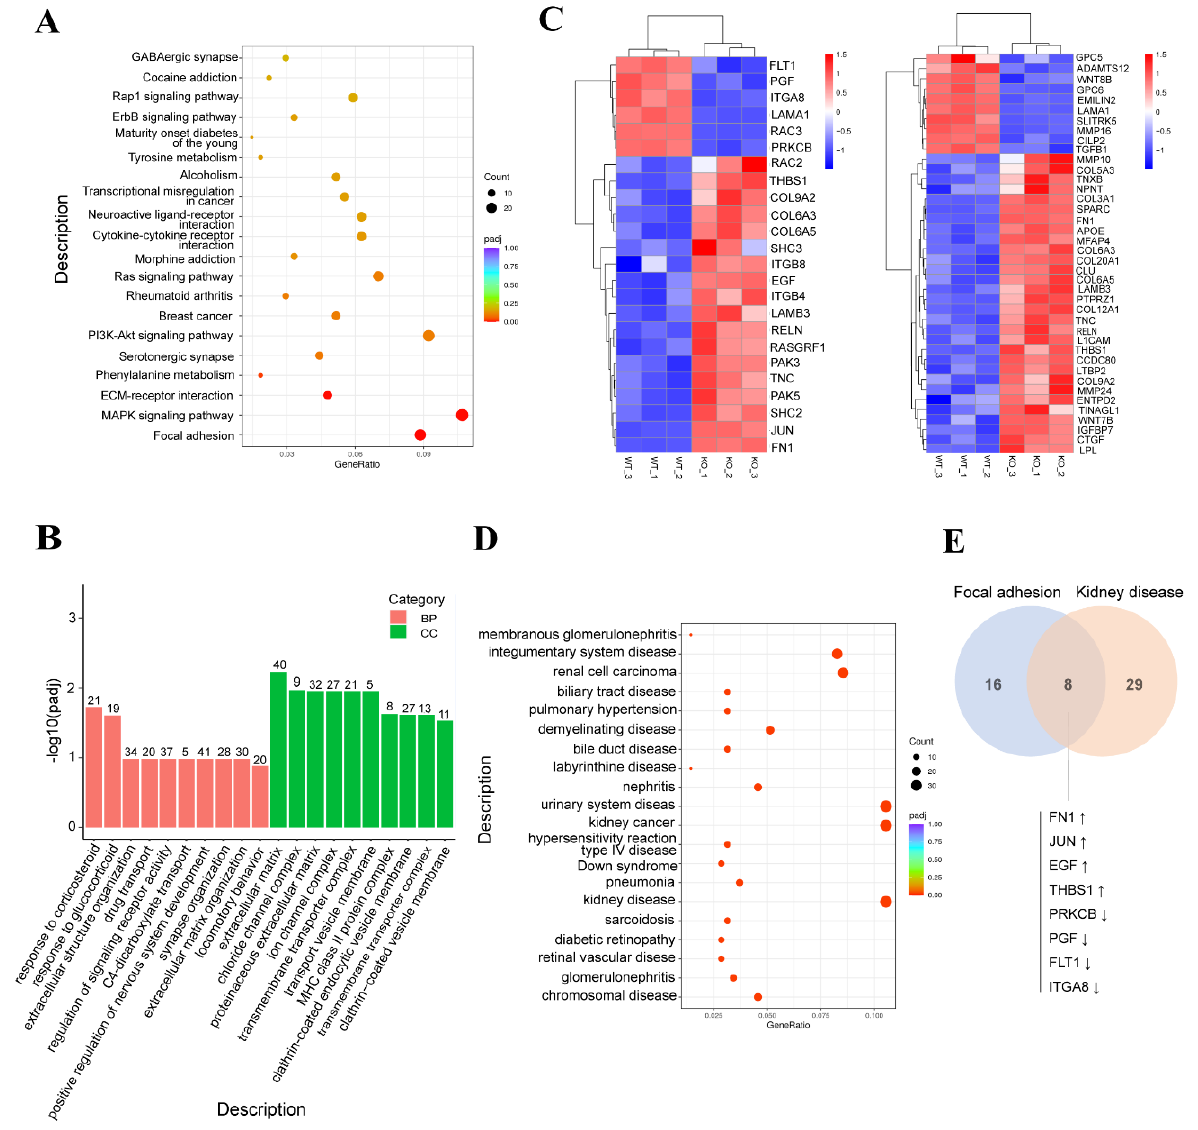
Figure 3. RNA sequencing analysis revealed differentially expressed genes (DEGs) enriched in two pathways. ( A ) KEGG pathway analysis of DEGs in WDR73 KO transcriptome. The top 20 most significantly enriched KEGG pathways are shown. ( B ) Gene Ontology (GO) functional clustering of DEGs. The top 10 most significantly affected categories are shown. BP, biological process; CC, cellular component). ( C ) The expression heatmap of focal adhesion and extracellular matrix-related genes. ( D ) Disease Ontology (DO) analysis of DEGs in WDR73 KO transcriptome. The top 20 most significantly enriched DO pathways are shown. ( E ) The Venn diagram used to identify the overlap DEGs of focal adhesion pathway and kidney disease, up arrow: up-regulated genes, down arrow: down-regulated genes. The ‘Count’ legend in ( A , D ) denotes the number of hit DEGs in the corresponding KEGG pathway or DO term.